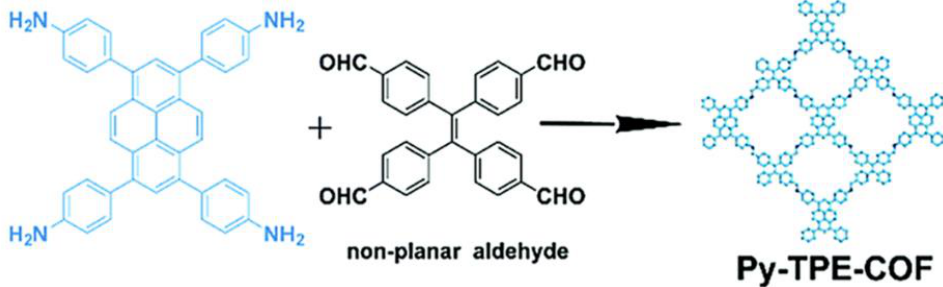
Figure 2. Imine-based 2D-COFs with high photoluminescence quantum yield in Ref. [38]. Repro- duced with permission from Ref. [38]. Copyright 2018, Royal Society of Chemistry.